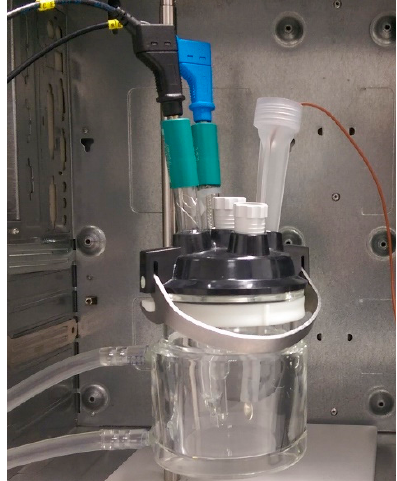
Figure 1. An electrochemical cell with a three-electrode setup.